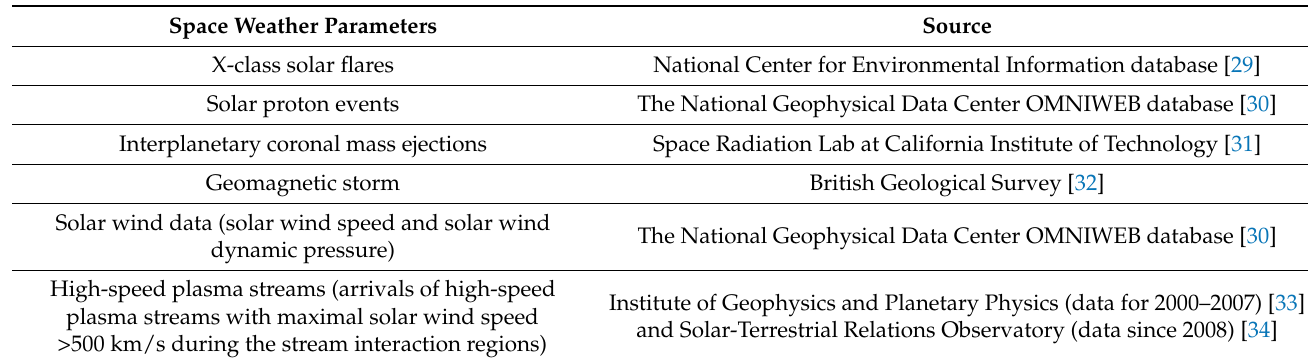
Table 2. Description of space weather